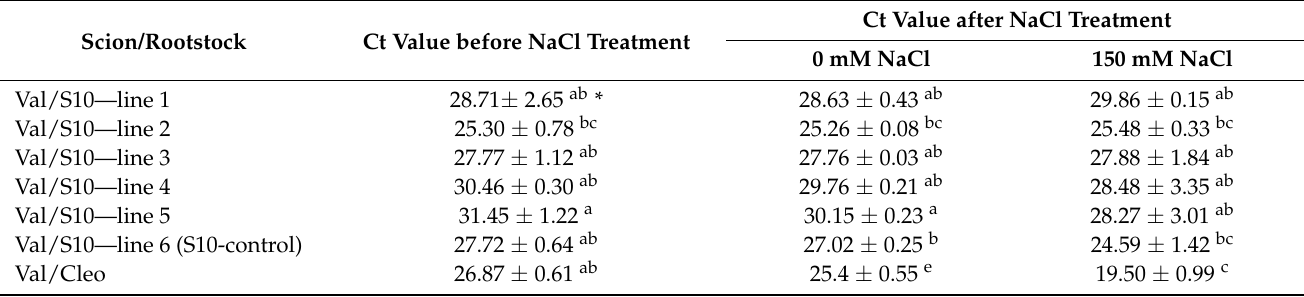
Ct Value after NaCl